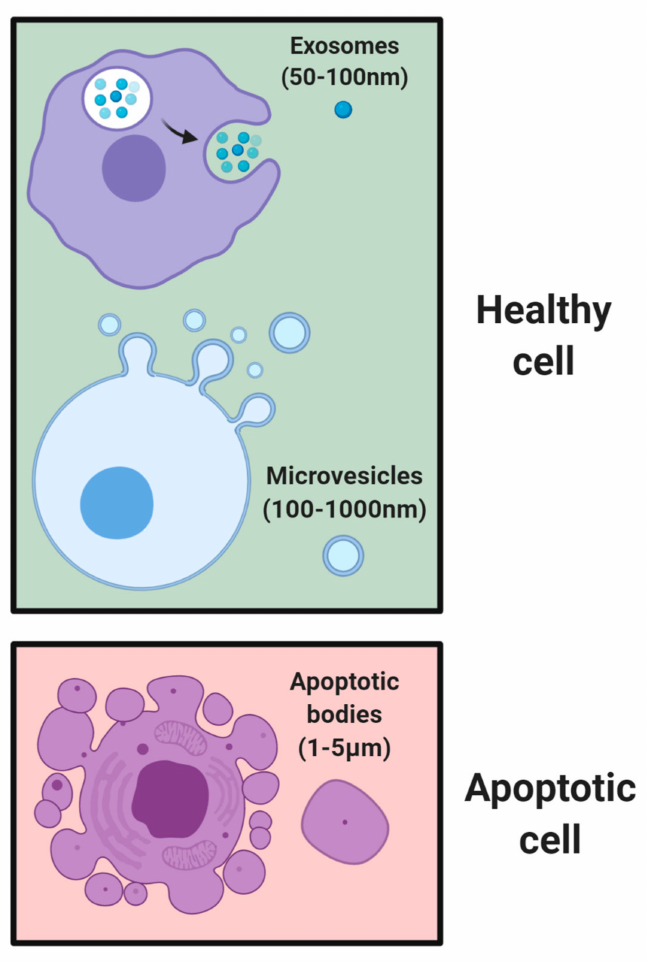
Figure 1. Subsets of EVs based on size. Healthy cells secrete exosomes of 50–100 nm in size and multivesicular bodies up to 1000 nm in size through blebbing of plasma membranes. Following cell death, apoptotic bodies of 1–5 µ m in size are